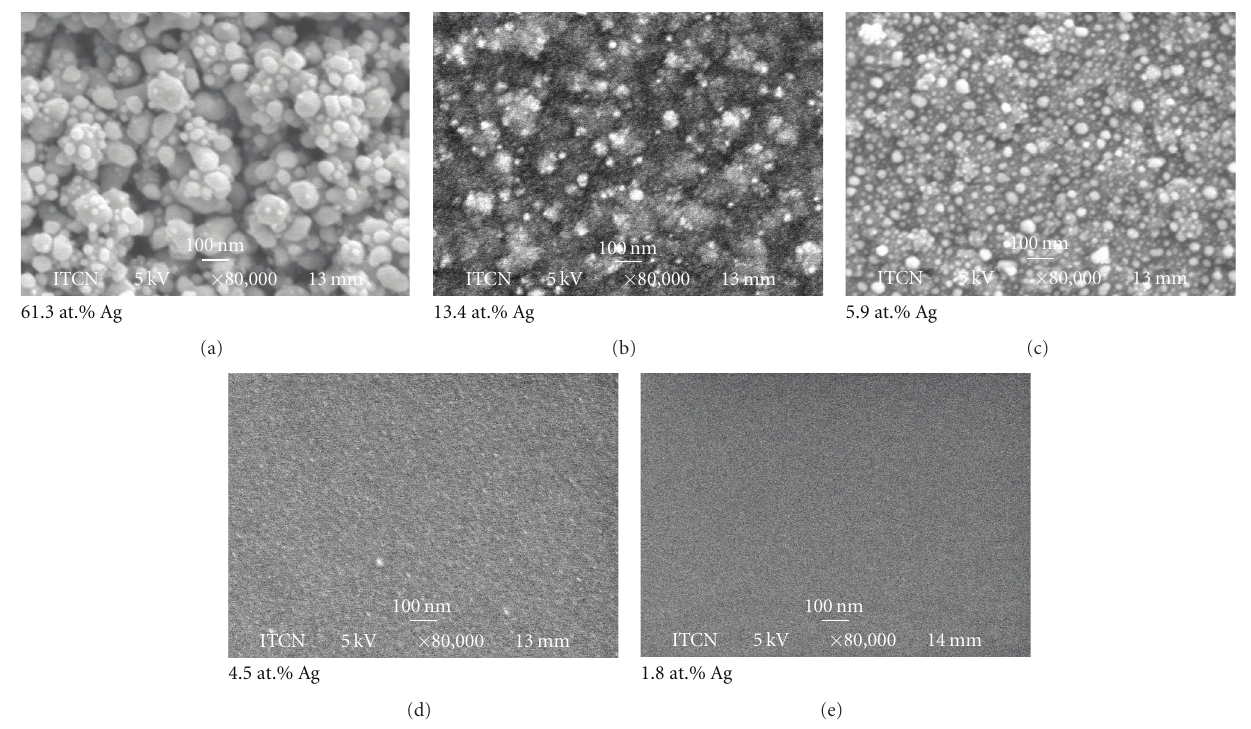
Figure 1: SEM images of the surfaces of silver-containing DLC